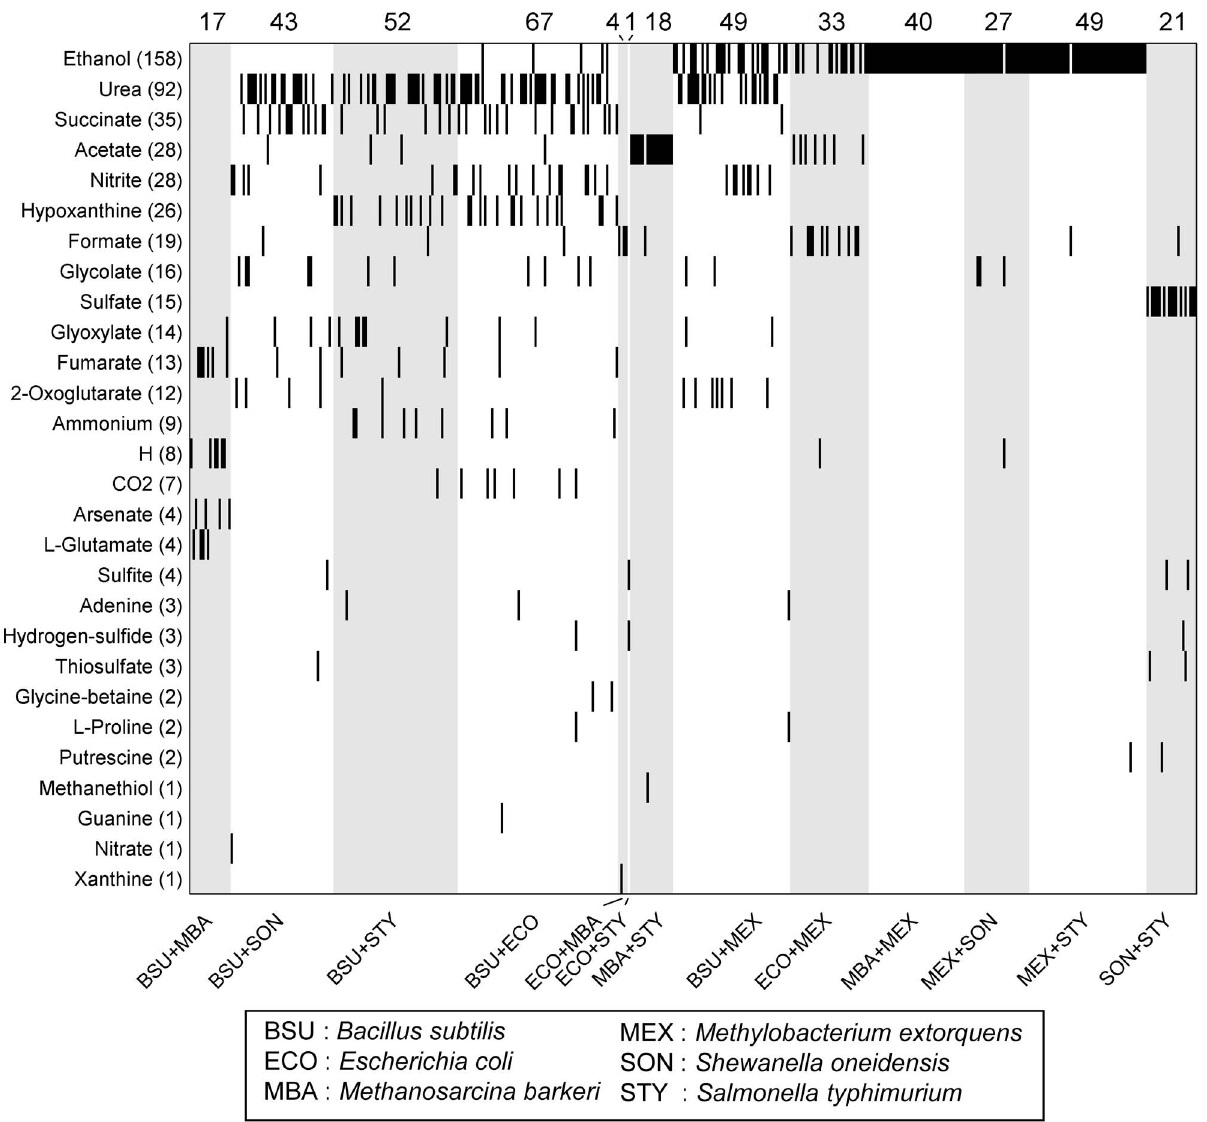
Figure 4. Emergent metabolites in simple two-species communities. Rows represent emergent metabolites and are ranked by their prevalence. Each column represents a specific two-species community growing in a random neutral medium. Secretion of a specific emergent metabolite in a certain community/medium combination is illustrated with a black bar. Only the 421 community/medium combinations that exhibited emergent biosynthetic capacity ( i.e. , at least one emergent metabolite) are shown. The species comprising each community are shown on the bottom, and the number of media in which emergent biosynthetic capacity occurred for each of these communities is shown on the top.